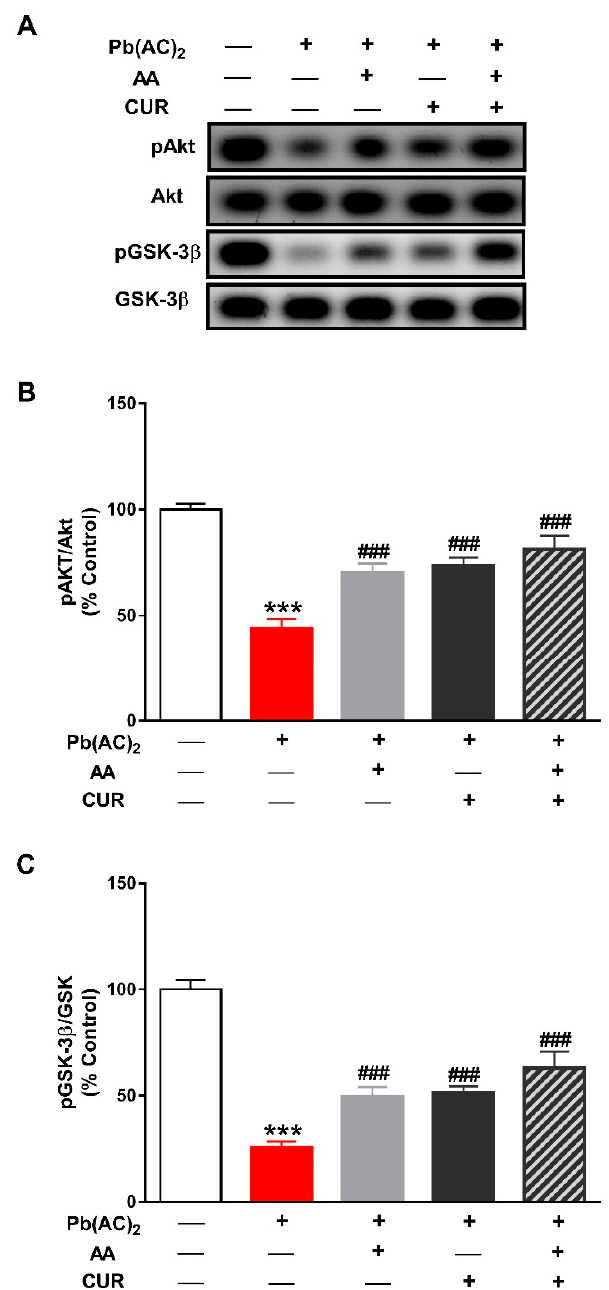
Figure 7. CUR up-regulates Akt / GSK-3 β signaling in in Pb(II)-induced rats. ( A ) Representative blots of pAkt, Akt, pGSK-3 β and GSK-3 β . ( B , C ) CUR, AA and their combination increased the phosphorylation levels of Akt ( B ) and GSK-3 β ( C ) in liver of Pb(II)-intoxicated rats. Data are expressed as Mean ± SEM, ( n = 6). *** p < 0.001 versus control and ### p < 0.001 versus Pb(II).